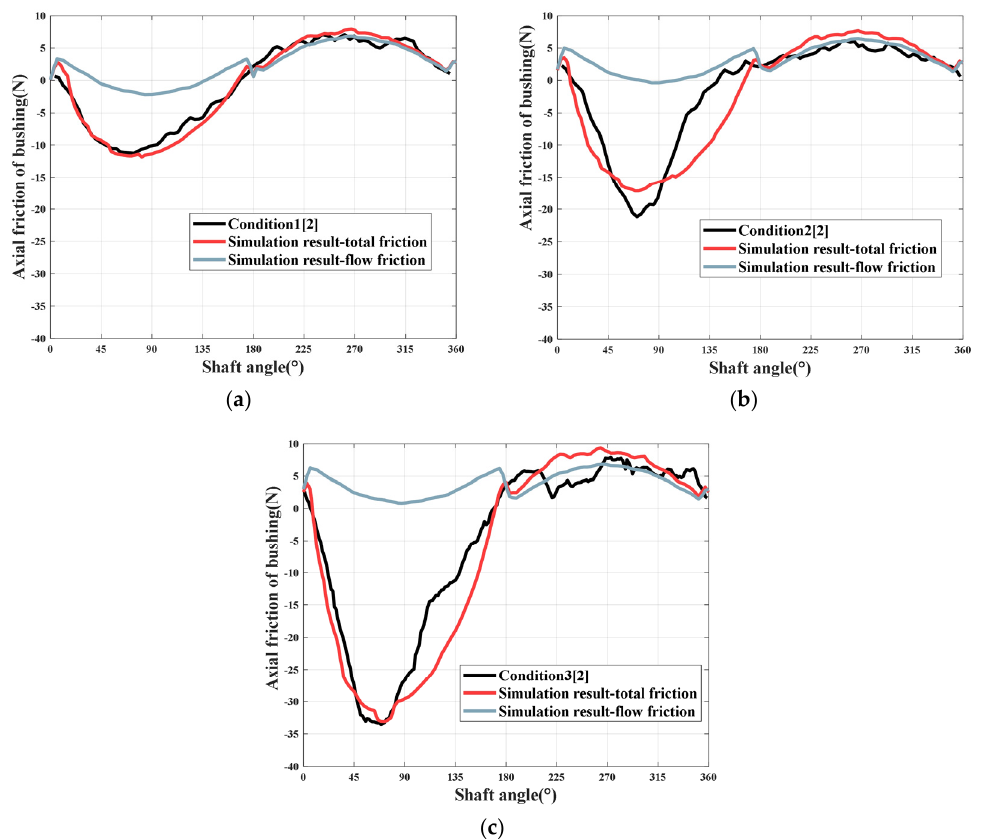
Figure 11. Comparison of the axial friction force exerted on the bushing: ( a ) Condition 1; ( b ) Condition 2; and ( c ) Condition 3. The change of temperature will influence the performance of the piston pump. There